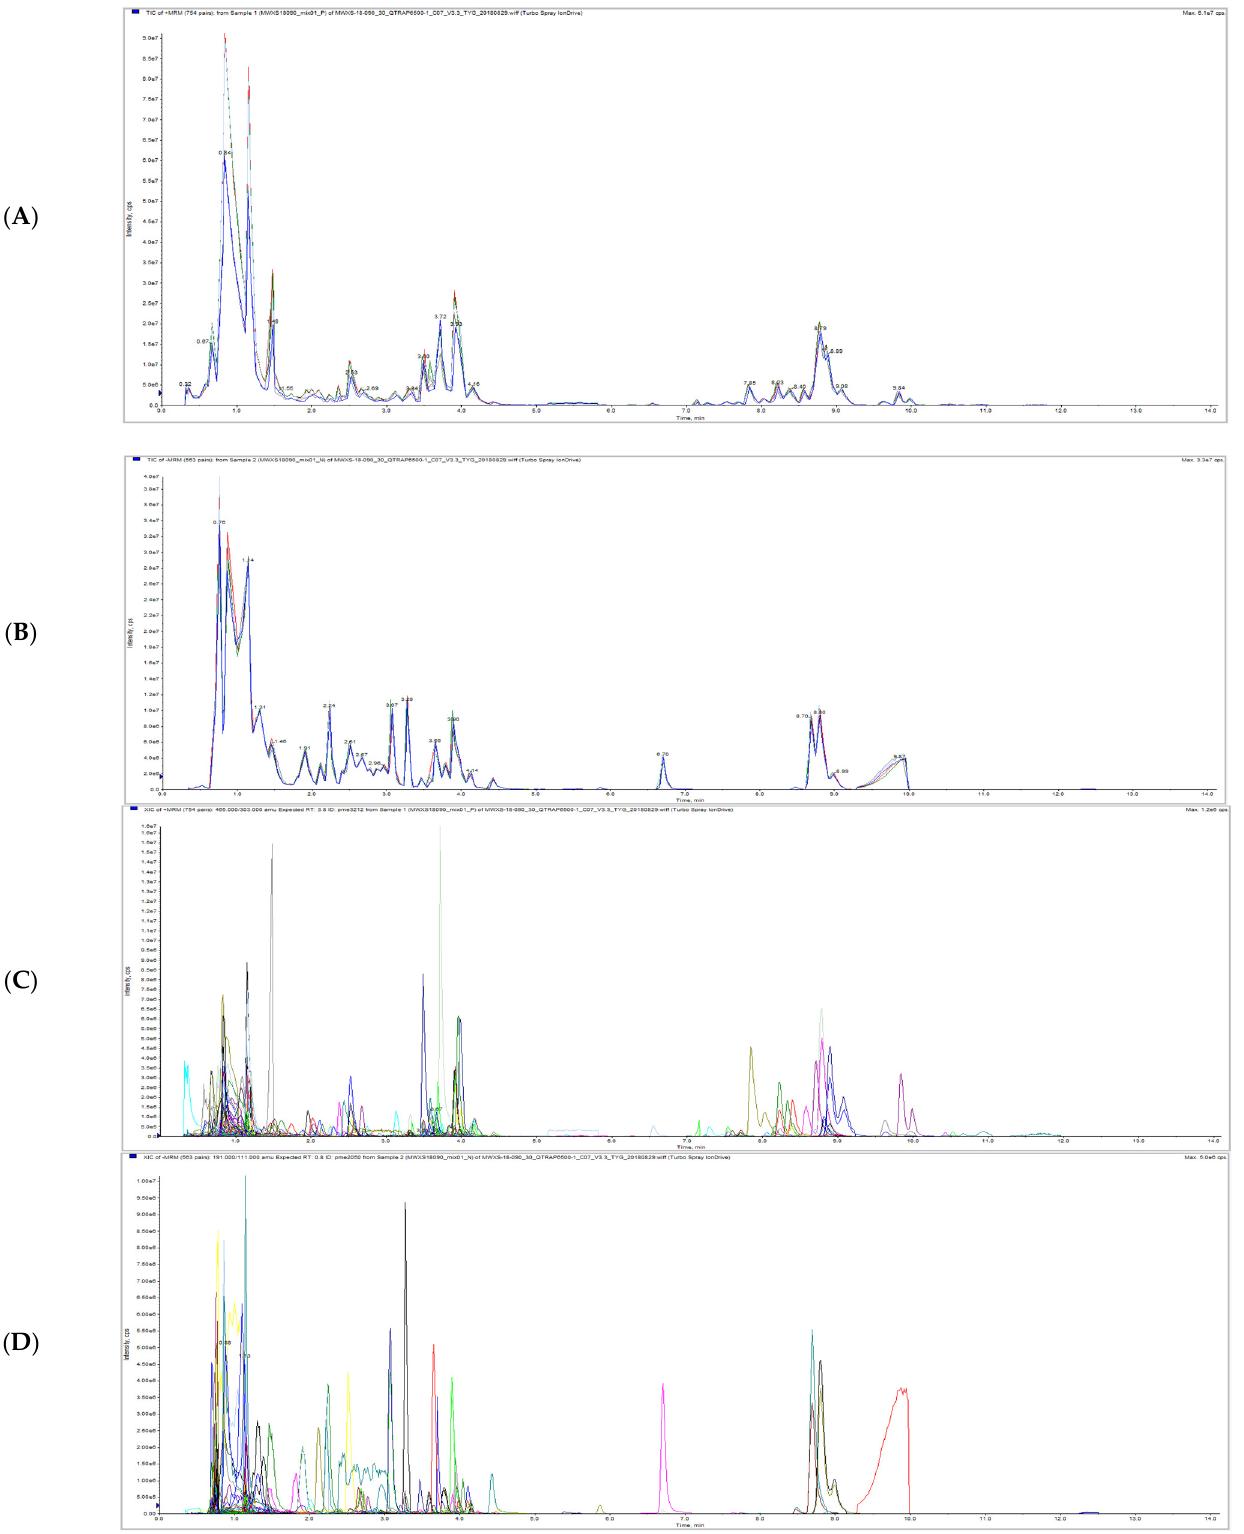
Figure 1. Total ions current overlap diagram ( A , B ) and multi-peak detection plot of metabolites in the multiple reaction monitoring mode ( C , D ) of litchi QC samples detected by mass spectrometry. Note: ( A , C ) is a positive ion mode, ( B , D ) is a negative ion mode and each mass spectrum peak with different colors represents a metabolite detected. The abscissa is the retention time (RT) of metabolite detection, and the ordinate is the ion current intensity (CPS, count per second) of ion detection.